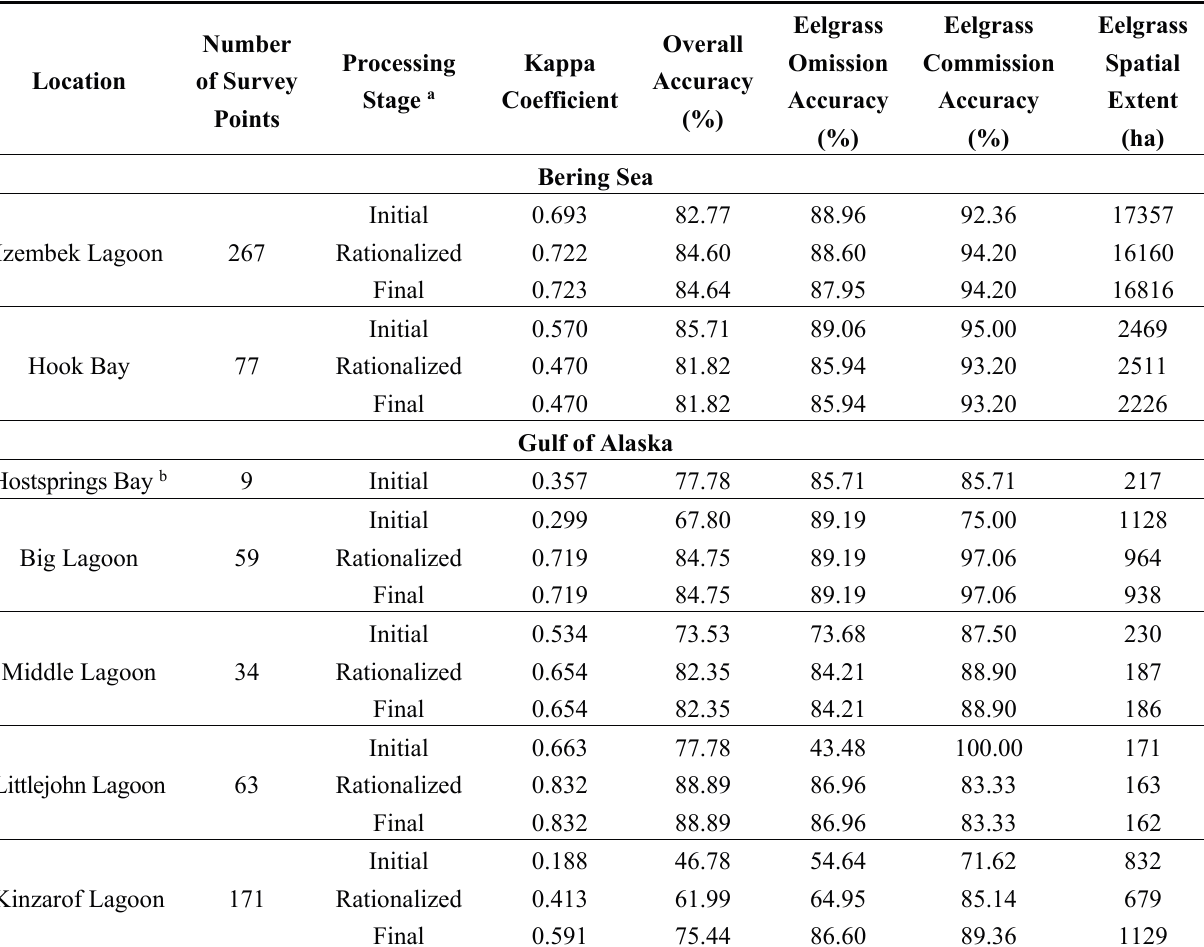
Table 4. Accuracy and spatial extent of eelgrass distribution during each step of the mapping process in embayments on the lower Alaska